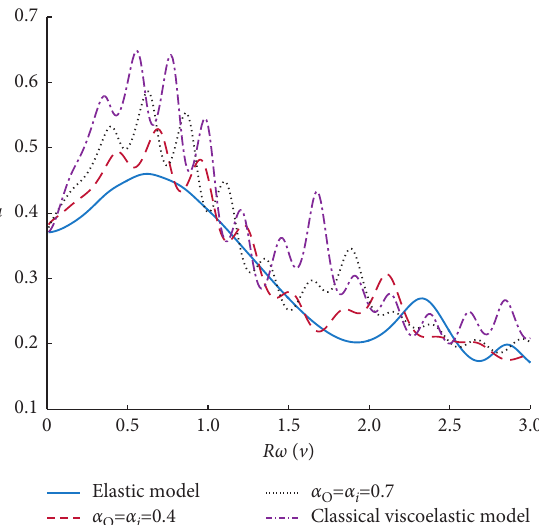
Figure 3: Curves of radial displacement varying with frequency for different